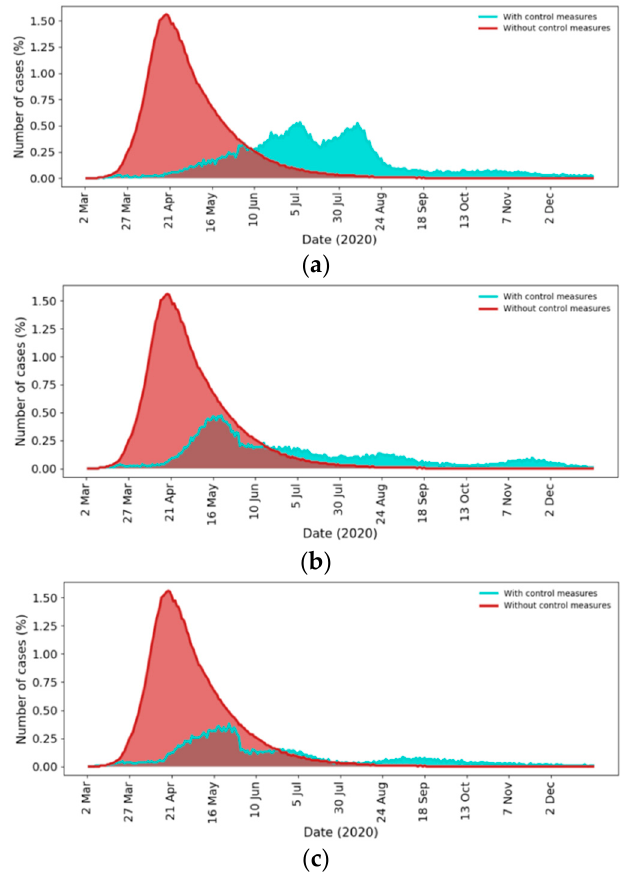
Figure 8. Prediction of future outbreak dynamics with (blue) and without (red) control measures. ( a ) Poor compliance to social distancing; ( b ) Moderate compliance to social distancing; ( c ) Strong compliance to social distancing.